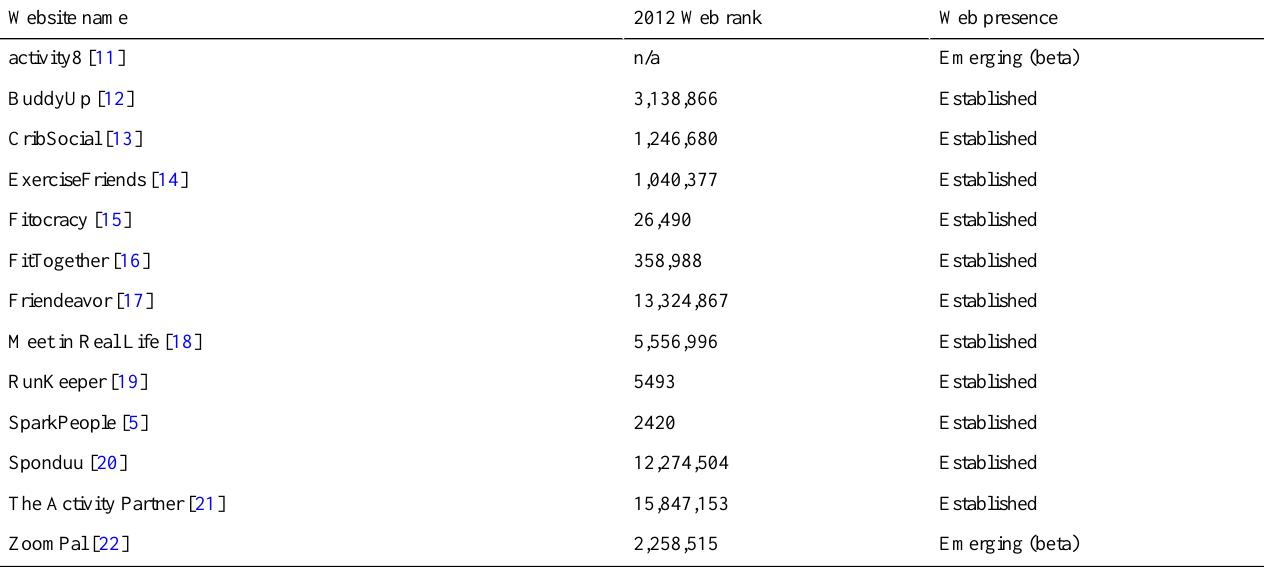
Table 2. Description of websites for online social networks that connect users to physical activity